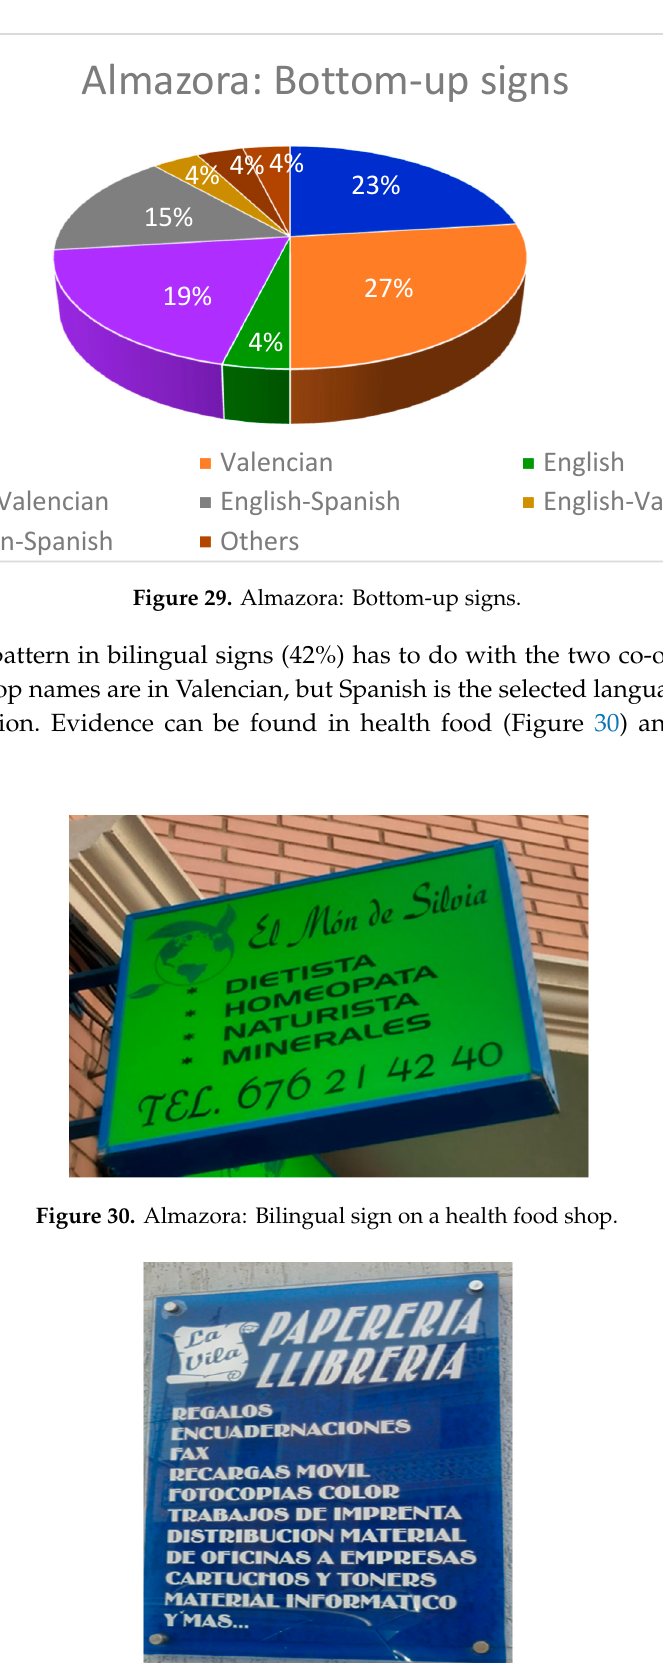
13 of 19 Figure 27. Benasal: Bilingual sign on a butchery . Figure 28. Benasal: Bilingual sign on a bank office .